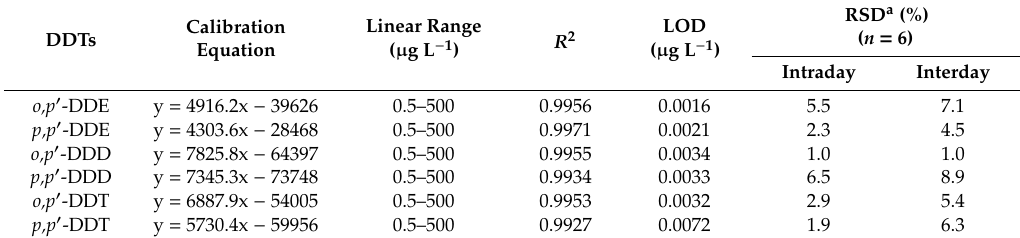
Table 1. Analytical parameters of the MM / ZIF-8 / IL-MSPE method for the analysis of DDTs from ultrapure water samples.